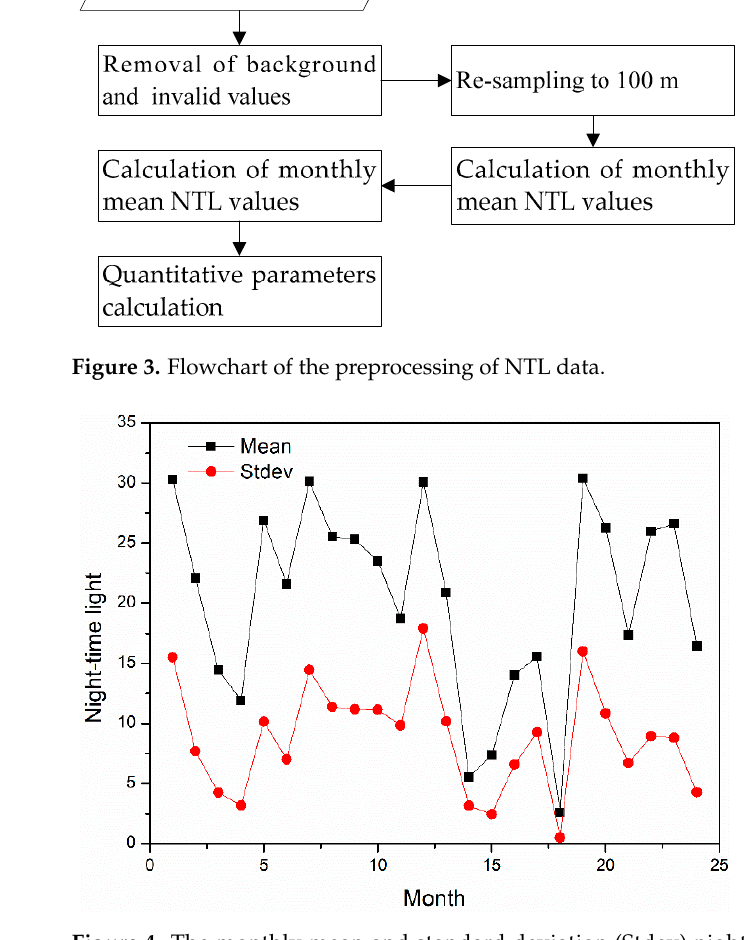
Table 3. Influence of COVID-19 on parks and surrounding 10 km buffer zones.